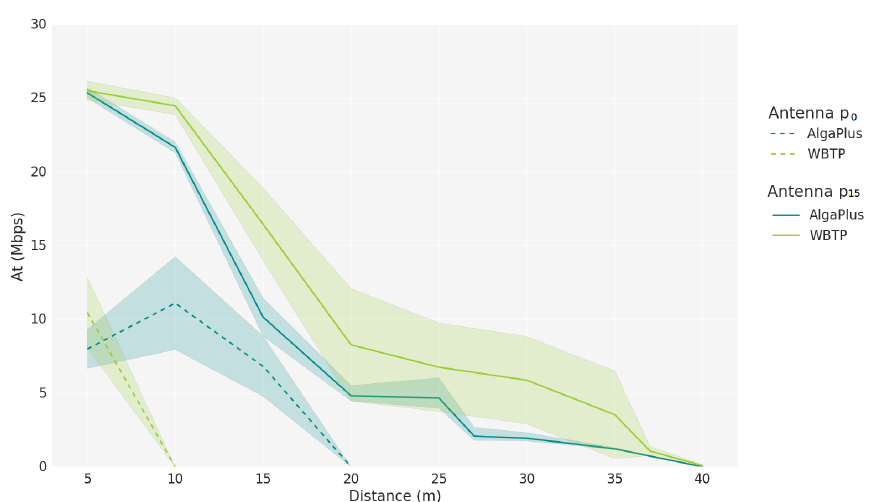
Figure 10. Achievable Throughput versus